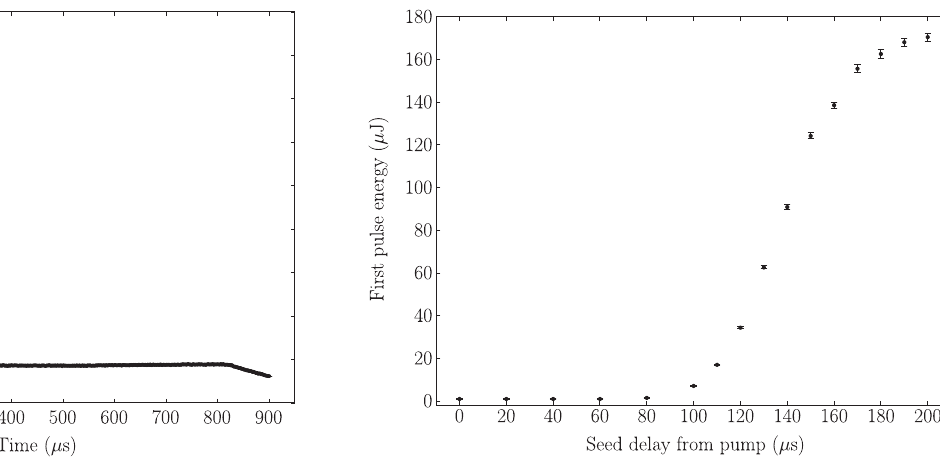
FIG. 7. Energy of the first pulse in the amplified train for various seed burst delays relative to the pump